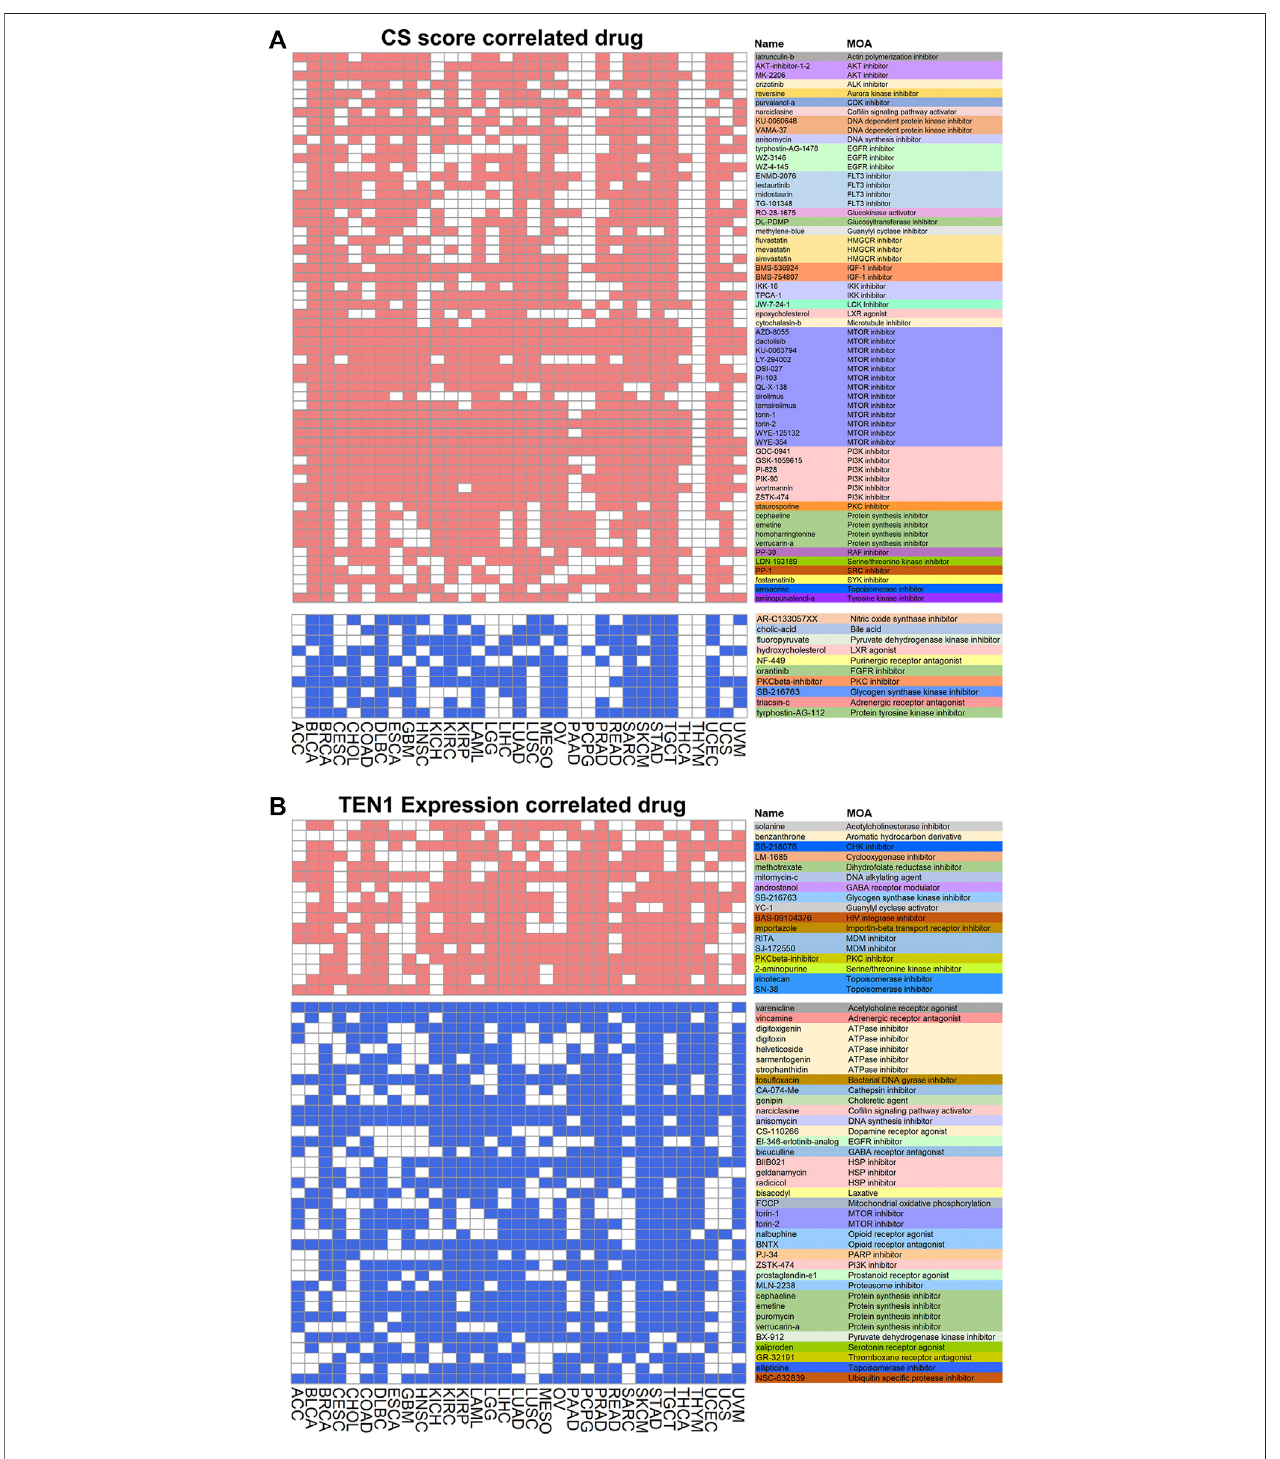
FIGURE 7 | Correlation of CST with drugs: (A,B) heatmaps show drugs related to CS score (A) and TEN1 expression (B) . The heatmap shows positive (red) and negative(blue)correlationofeachcompoundfromtheconnectivitymapforeachcancertype.Asigni fi cantcorrelationisde fi nedwithenrichmentscore > 90or < − 90.The functions of the drug are annotated in different colors.